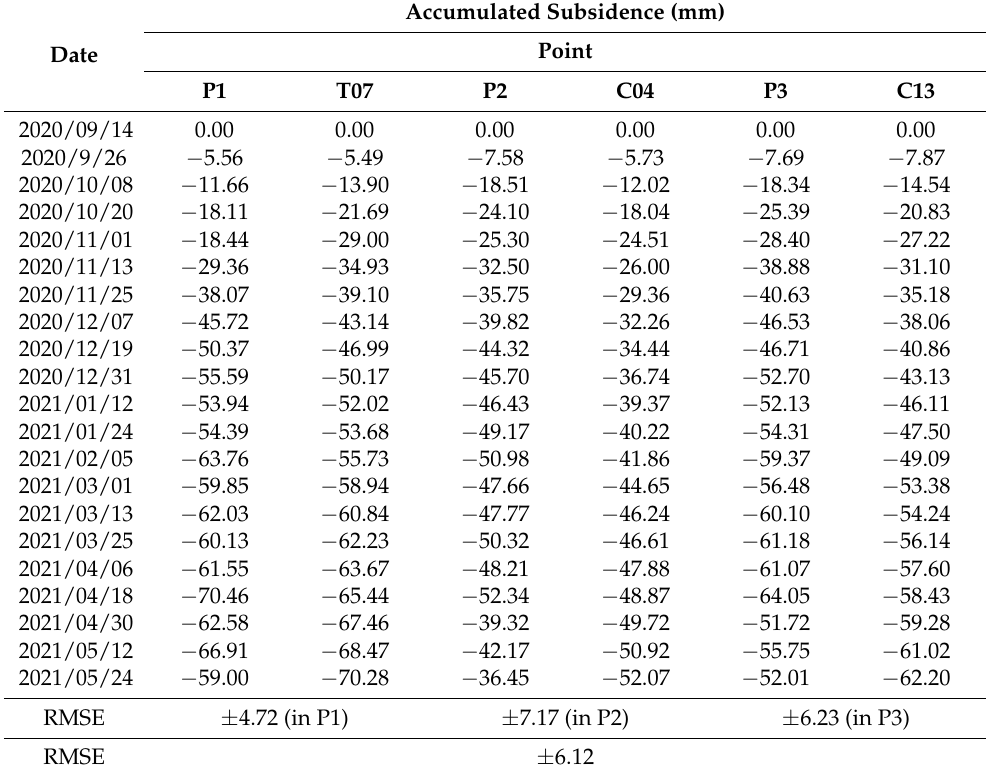
Table 2. Validation of temporal InSAR monitoring results.